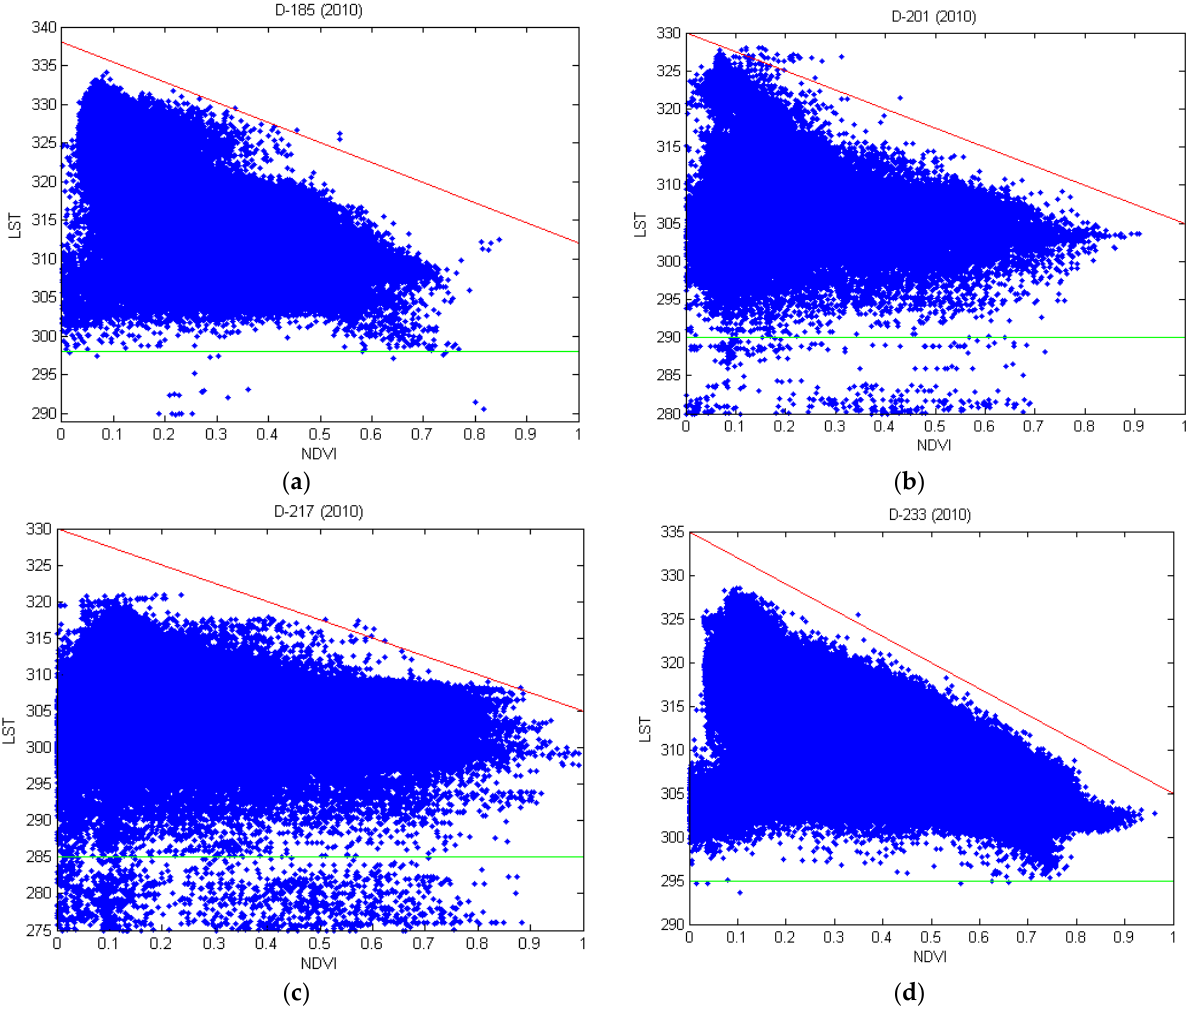
Figure 9. VTCI scatter plot of soil moisture contents in terms of warm and cold edges during 2010, with ( a ) at D ‐ 185, ( b ) at D ‐ 201 with heavy observed rainfall, ( c ) at D ‐ 217 demonstrating the flood events and extreme wetness, and ( d ) at D ‐ 233 showing the runoff of the water (normality) based on VTCI ‐ approached scale categorization, dry to wet or (0.0 to 1.0).